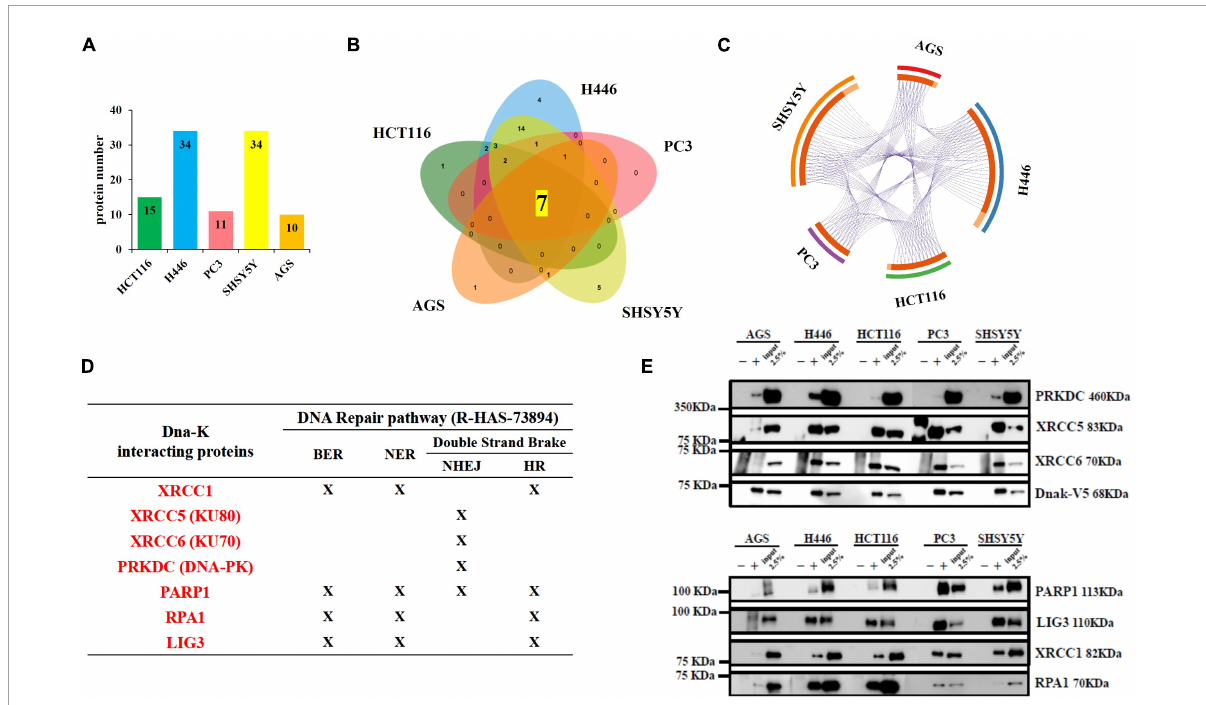
FIGURE5 Lists of the total number of proteins immunoprecipitated by DnaK-V5 and identified by mass spectrometry analysis in each cell type that are part of the DNA repair Reactome pathway (R-HSA-73894). (A) A total of 34 proteins were identified (see Supplementary Tables 1, 2 ). The histogram indicates the number of hits for each cell type. (B) A Venn diagram visualizes the number of shared and unique proteins obtained from each cell type. Of these, 7 proteins were shared among all five human cell lines analyzed. (C) The Circos plot shows the overlaps between the proteins from theDNA repair pathway. On the outside, each arc represents the identity of the 5 cell lines (red for AGS, blue for H446, green for HCT116, purple for PC3 and orange for SH-SY5Y); on the inside, each arc represents a protein list, where each protein has a spot on the arc. The dark orange color of the inside arc represents the DNA repair proteins that appear in multiple lists and the light orange color of the inside arc represents DNA repair proteins that are unique to that cell type list. Purple lines link the proteins that are shared by multiple cell types. The greater the number of purple links and the longer are the dark orange arcs. This implies a greater overlap among the protein from each cell line. A full list of the total 34 isolated proteins from the DNA repair Reactome pathway is given in Supplementary Table 2 . (D) Table indicating the membership of the seven proteins in the 4 DNA repair pathways of Base Excision Repair (BER), Nucleotide Excision Repair (NER), Non-Homologous End Joining (NHEJ) and Homologous Recombination (HR). (E) Western blot from DnaK immunoprecipitation comparing the five cancer cell lines. On the left side, the Molecular Weight (MW) Marker is indicated. On the right side, the name and MW of each validated protein are given. For each of the 5 cell types, three samples were loaded: the immunoprecipitated DnaK-transfected lysate with the antibody isotype control, the immunoprecipitated DnaK-transfected lysate with anti-V5 antibody and 2.5% load of the DnaK-transfected lysate used for the